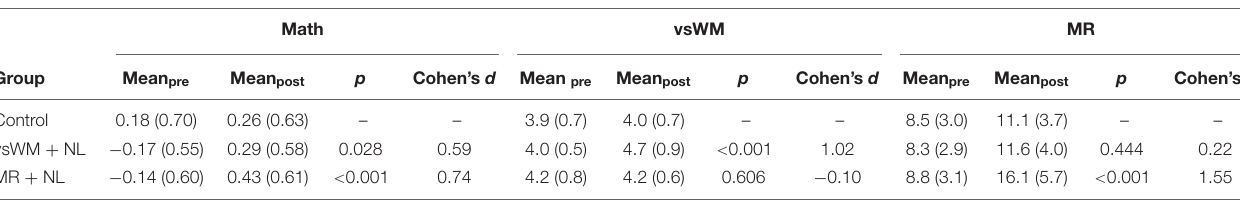
FIGURE 3 | The pre-post performance of each group on mathematics (A) , visual-spatial working memory (B) , and mental rotation (C) . TABLE 2 | Results of the planned contrasts for each behavioral outcome.